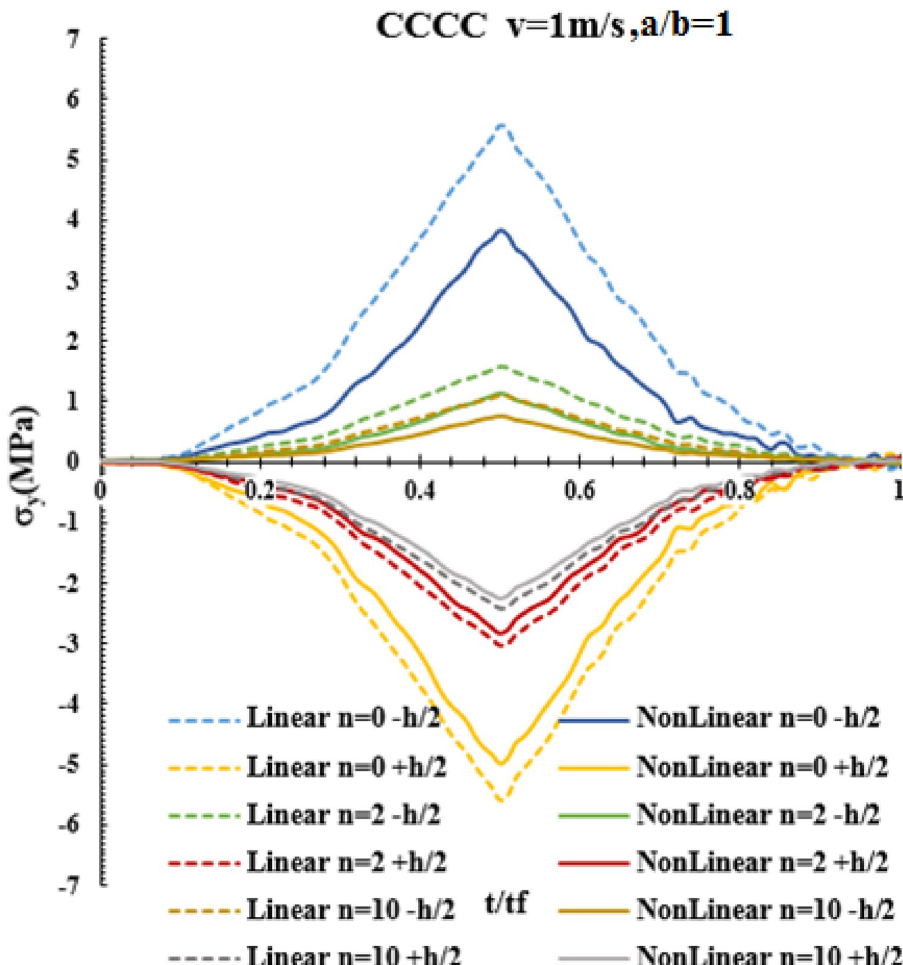
Fig. 22 The effect of material gradient index on transient dis- tribution of 𝜎 yy for center-point of the plate (CCCC, v = 1